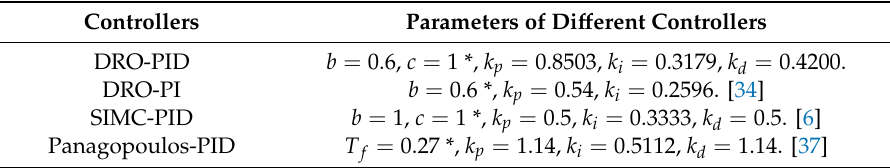
Table 2. Parameters of di ff erent controllers for Example 1.